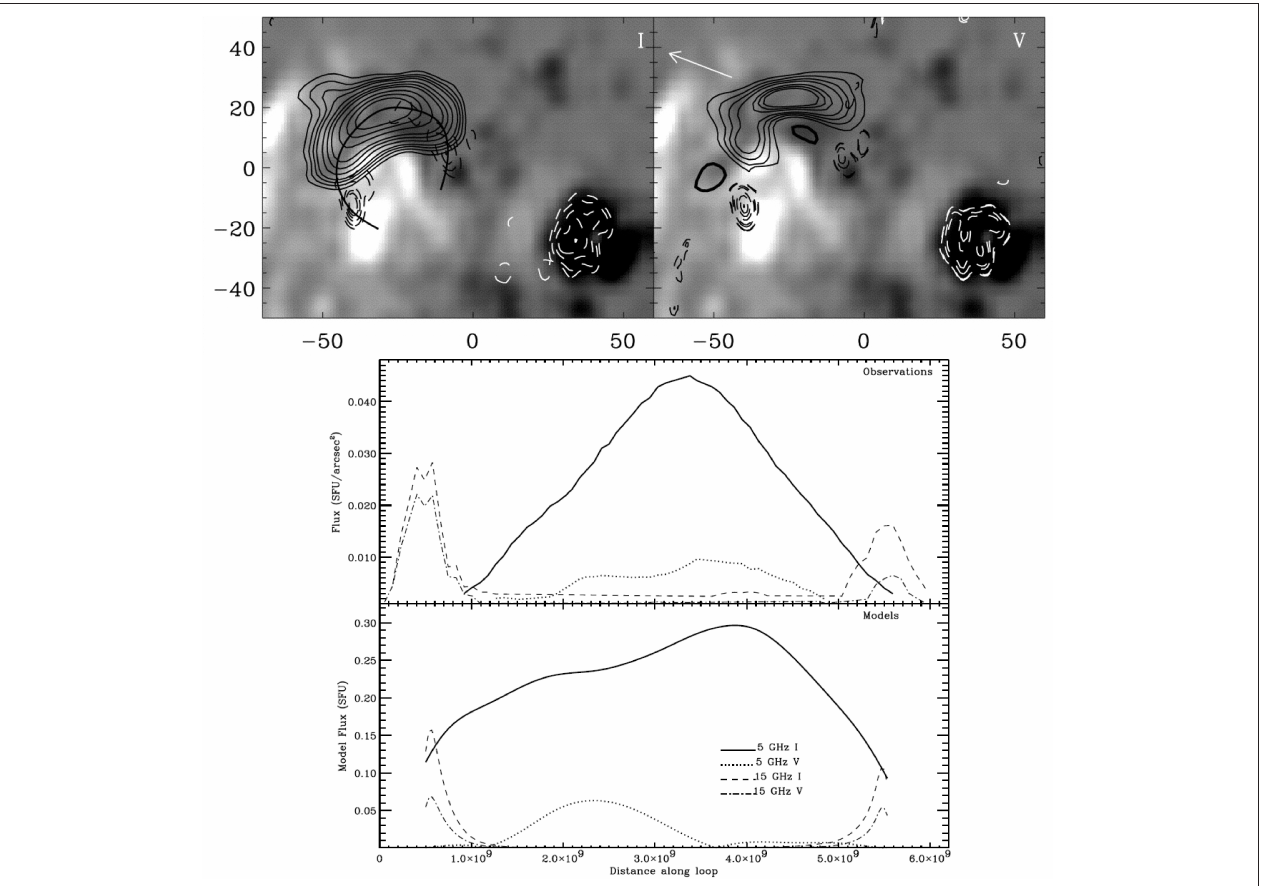
FIGURE 14 | Top row : The 1992 July 1 flare. Contour plots of the flare radio emission maximum observed by the VLA. The gray-scale background is a photospheric magnetogram. The I maps are on the left, and the V maps on the right. The solid and dashed contours show 5 and 15 GHz emission, respectively. In the 5 GHz V map, the thick contours represent positive brightness temperatures. In both images the white contours show emission from the sunspot at 15 GHz. The arrow shows the direction of the limb. Middle row : One-dimensional profiles of the flare computed along the black curve of the top left panel. Bottom row : spatial profiles of the gyrosynchrotron models (see text for details) as a function of the distance along the loop. For comparison with the observations, the profiles have been computed after the models were convolved with the appropriate VLA beam. In both panels the absolute values of the V profiles are presented (adapted from Nindos et al., 2000b ). © AAS. Reproduced with